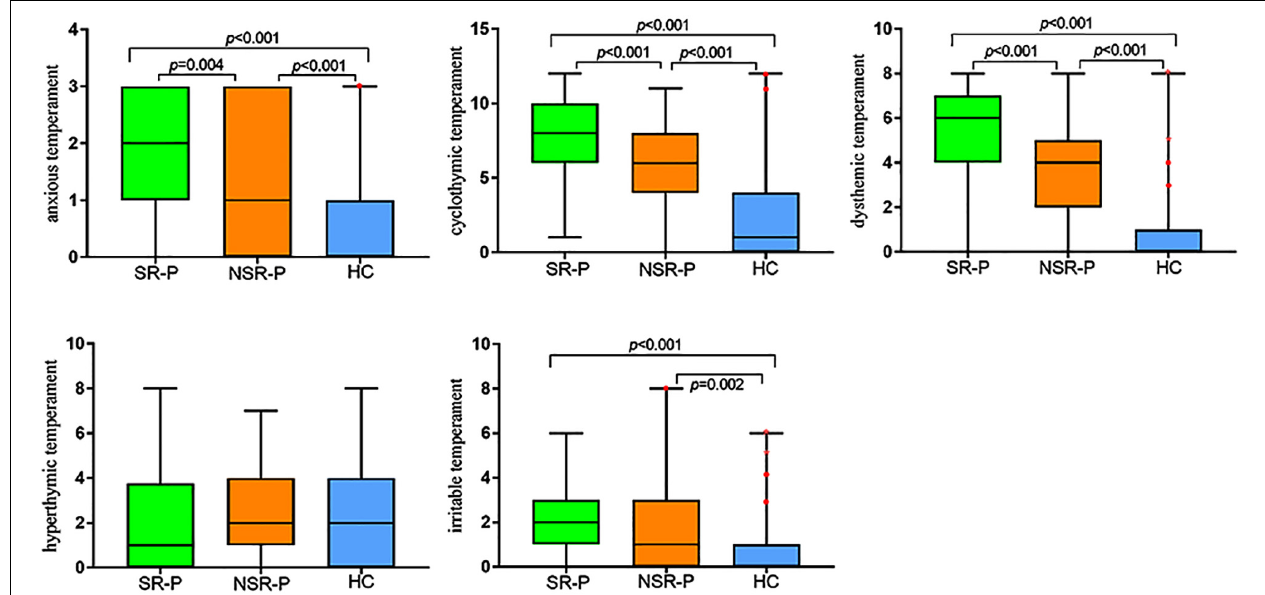
FIGURE 1 | Box plots of the TEMPS-A subscales across the groups of SR-P, NSR-P and HC. The solid lines show the medians, and the boxes show the interquartile ranges. Outlier ( • ) means cases with values between 1.5 and 3 box lengths from the upper or lower edge of the box. Asterisk (*) means cases with values more than 3 box lengths from the upper or lower edge of the box. The box length is the interquartile range. SR-P: suicidal risk MDD patients; NSR-P: non-suicidal risk MDD patients; and HC: healthy control. P -value is adjusted by Bonferroni